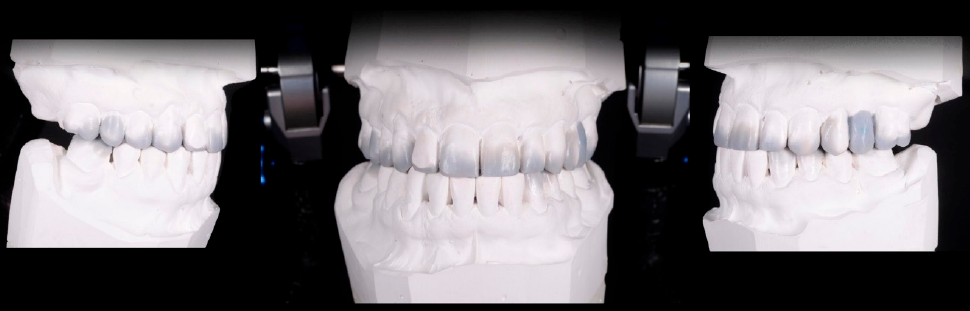
Figure 1. Esthetic and functional analysis of a patient: ( a ) facial analysis; ( b ) dento-gingival analysis.